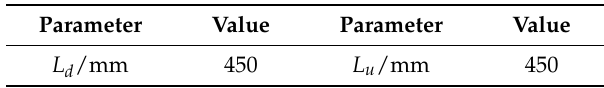
Table 2. Parameters of the mobile robot.